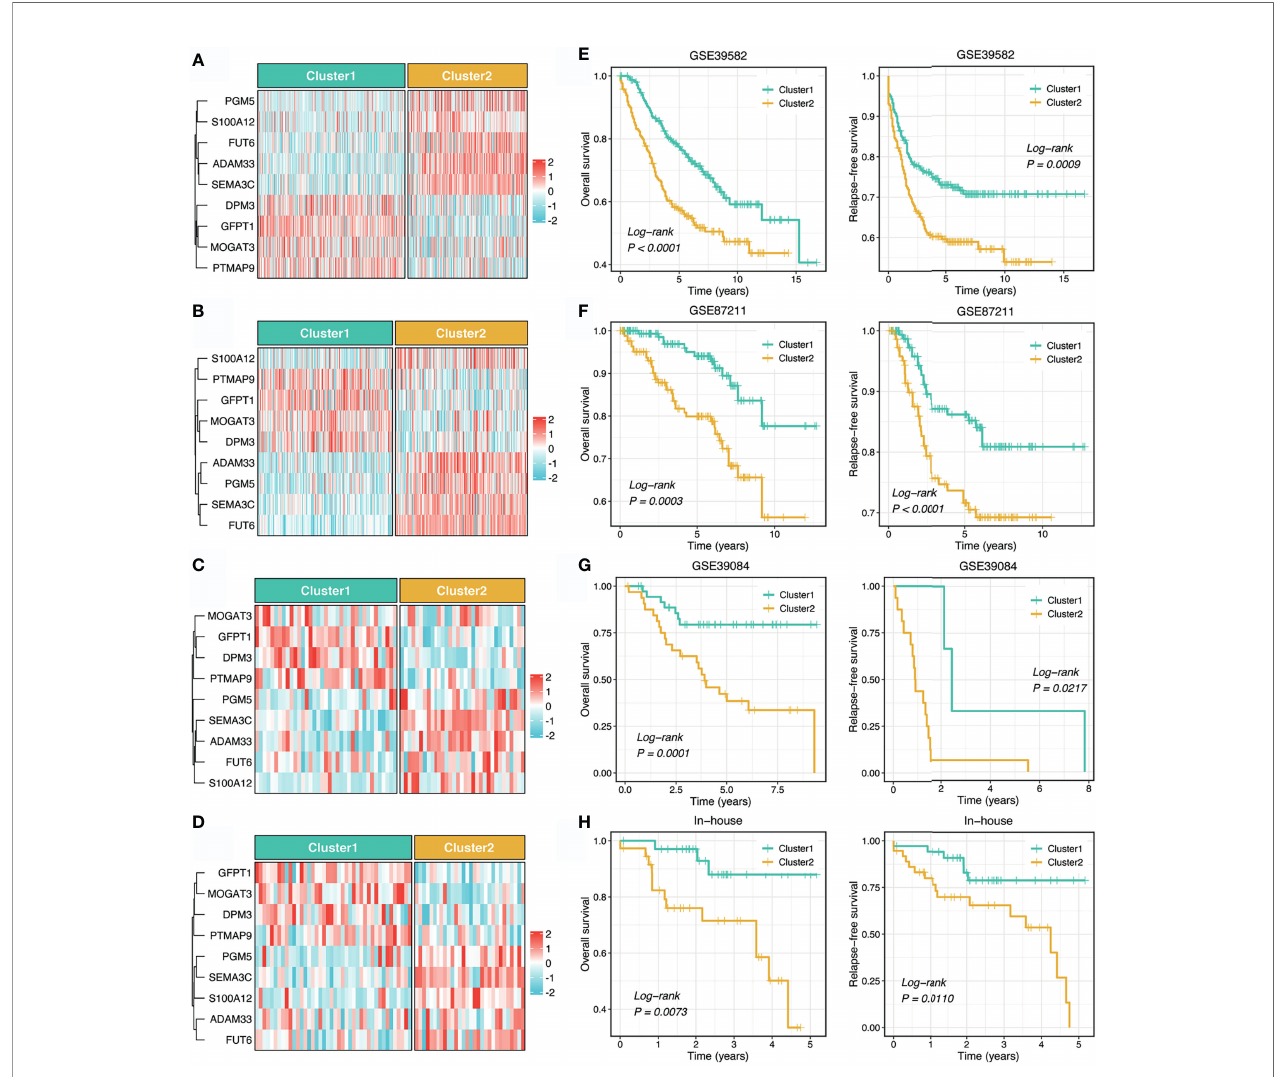
FIGURE 3 | Validation and reproduction of the stemness clusters in clinical samples. (A – D) . Using the stemness cluster predictor, CRC patients from different cohorts were categorized into C1 or C2 in GSE39582 (A) , GSE87211 (B) , GSE39084 (C) , and in-house (D) cohorts. (E – H) . Kaplan-Meier curves of OS and RFS according to the stemness clusters in GSE39582 (E) , GSE87211 (F) , GSE39084 (G) , and in-house (H)